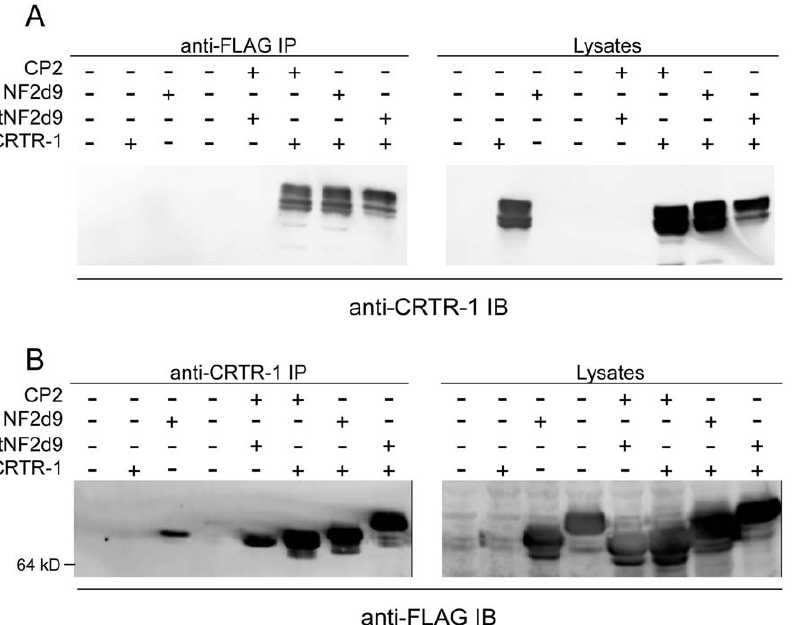
Figure 3. CRTR-1 co-immunoprecipitates with other CP2 family members. HEK293T cells were co-transfected with pEF-IRES-puro6 expression plasmids encoding CRTR-1 and FLAG-CP2, FLAG-NF2d9 or FLAG-altNF2d9, as indicated. Whole cell lysates were immunoprecipitated (IP) with (A) anti-FLAG (M2) antibody or (B) anti-CRTR-1 antibody and immunoblotted (IB) with anti-CRTR-1 or anti-FLAG antibodies respectively. Western blot analysis of input lysates is